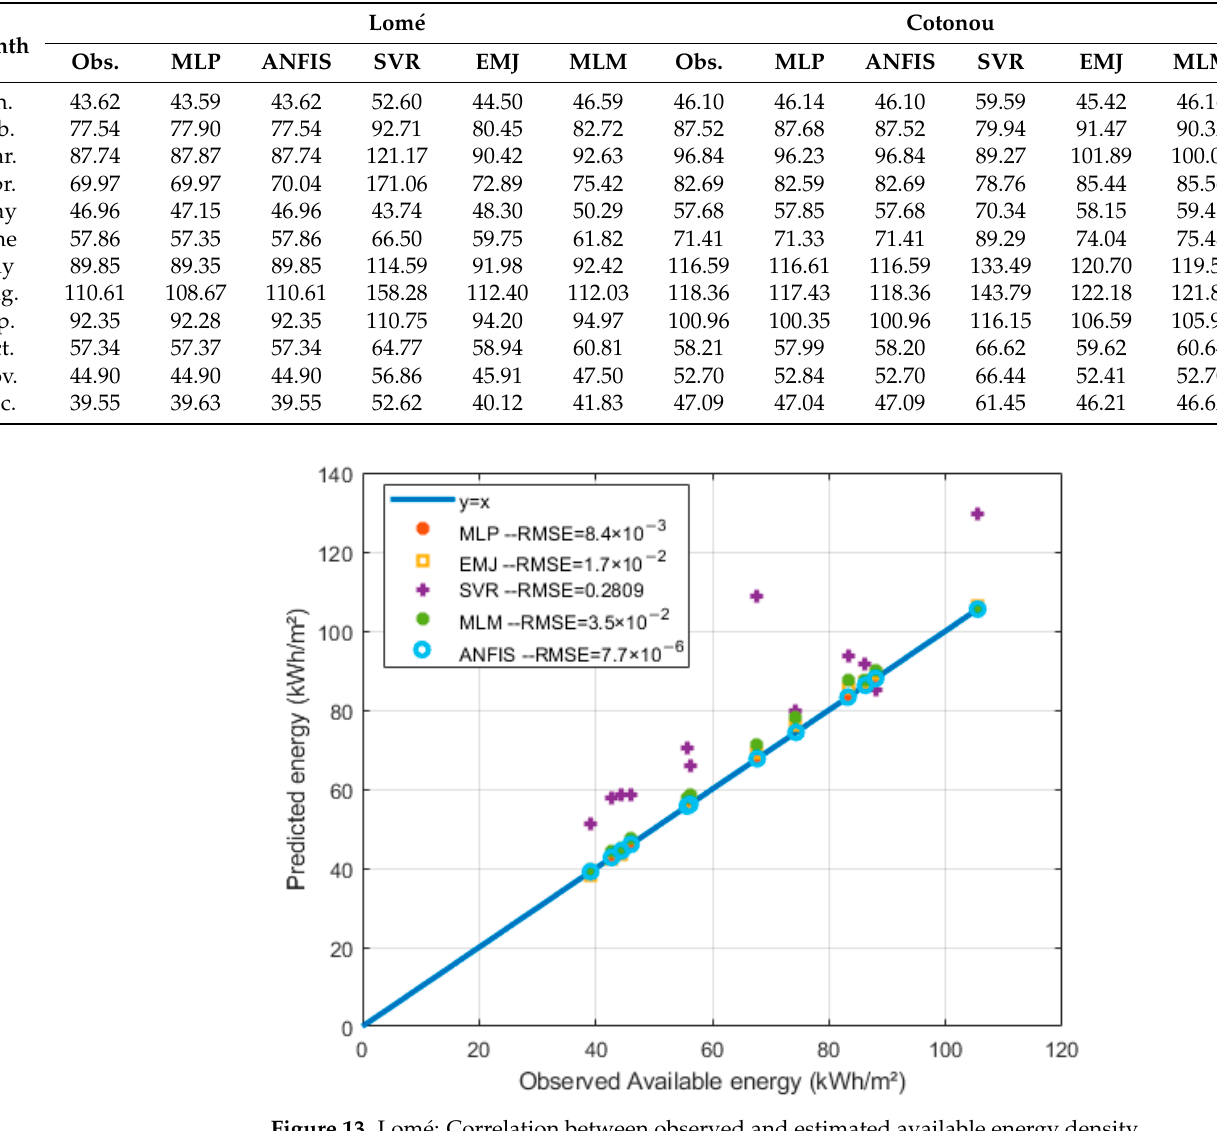
Table 11. Available energy density estimation (kWh/m 2 ).